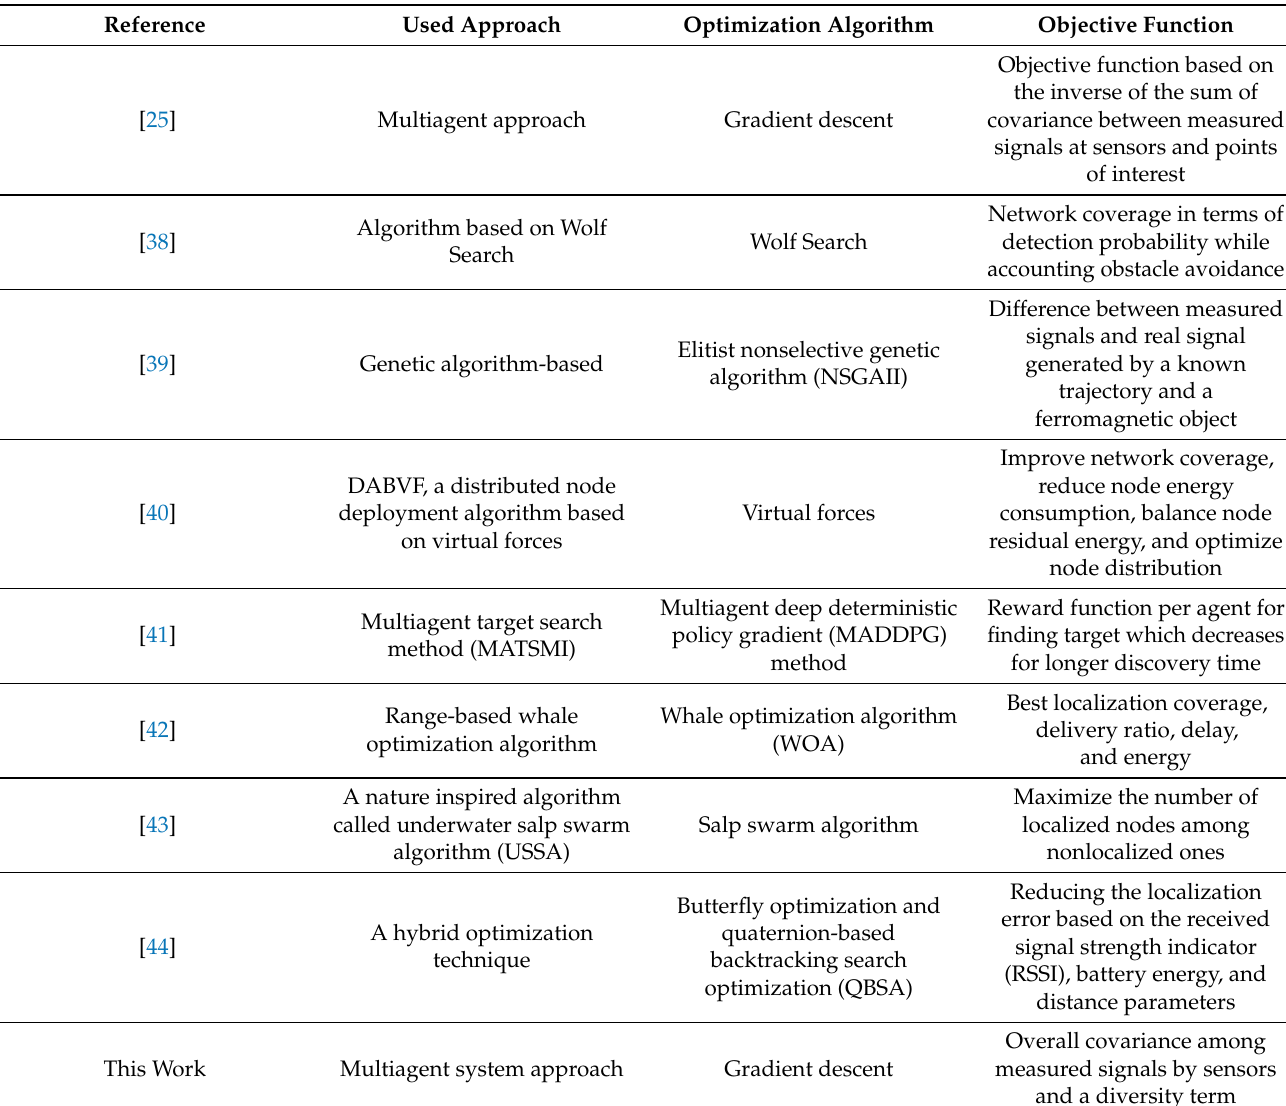
Table 1. Qualitative comparison of related